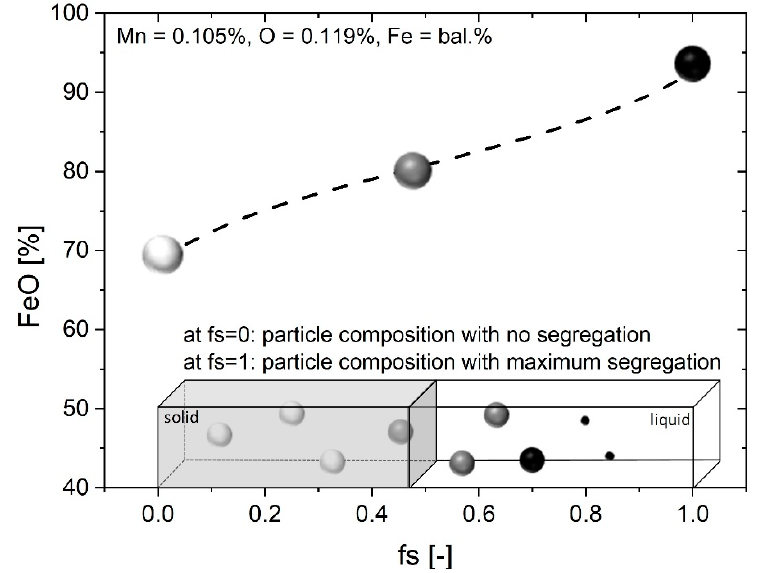
Figure 1. Enrichment of nonmetallic phase during solidification according to [27].